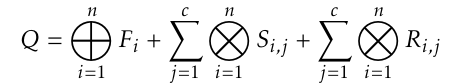
Figure 5. Automata for batch service